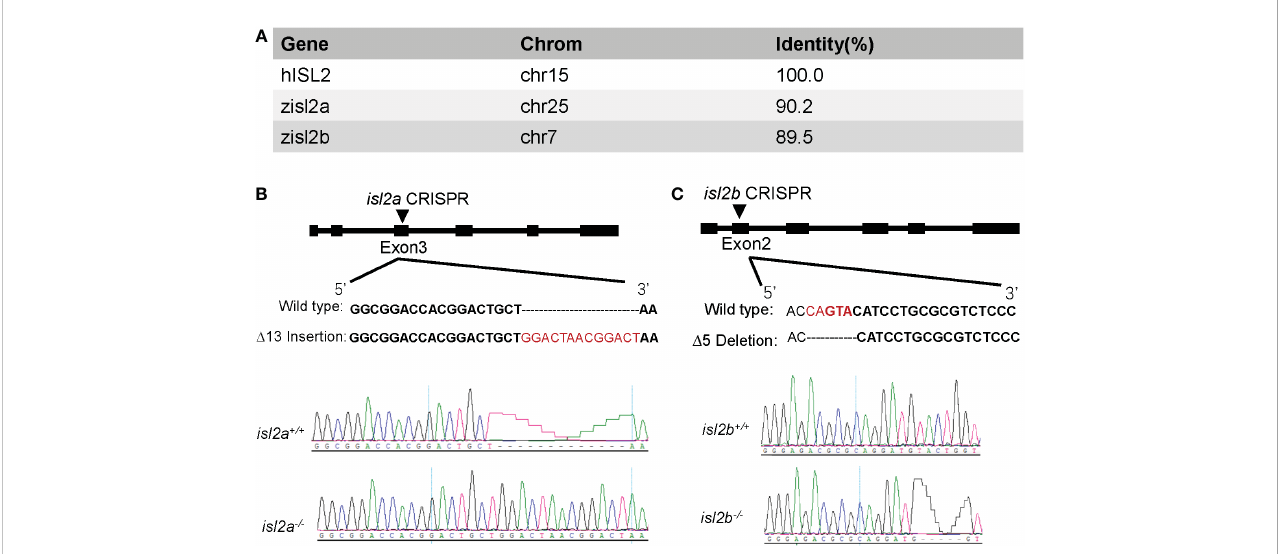
FIGURE 1 Generation of isl2a and isl2b knockout zebra fi sh utilizing CRISPR-Cas9 technology. (A) Amino acid identity between zebra fi sh and human ISL2 proteins was performed using UCSC Blat software. (B) The isl2a -CRISPR-target site (black bold words) was designed in exon3 of isl2a and the CRISPR/Cas9- induced insertion of 13 nucleotides (red words) was selected for further investigation. (C) In the case of isl2b , the CRISPR-target site (bold words) was designed in exon2, and the induced deletion of fi ve nucleotides (red words) was selected for further investigation. Genotypes, including wild-type and homozygotes, were analyzed and shown in the bottom panel. Both genotypes were predicted to produce truncated